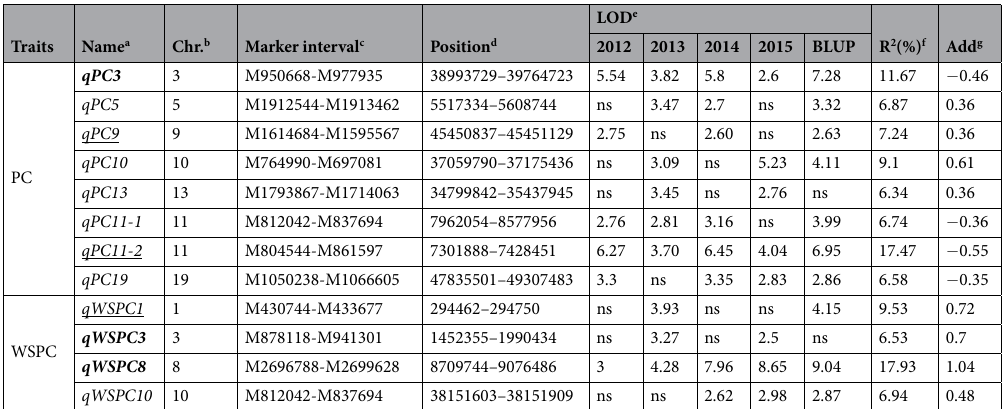
Table 2. Nine QTLs associated with protein content (PC) and water-soluble protein content (WSPC) across four environments in RIL population. a The name of the QTL is defined by the abbreviation of traits and the chromosome number. b Chromosome; c confidence interval of QTL; d The interval of physical distance in soybean genome; e the logarithm of odds score; f the mean phenotypic variance explained by related QTL; g the mean additive effect of QTLs. The QTLs in bold were detected simultaneously by ICIM and GCIM, and the underlined QTLs were detected by GCIM